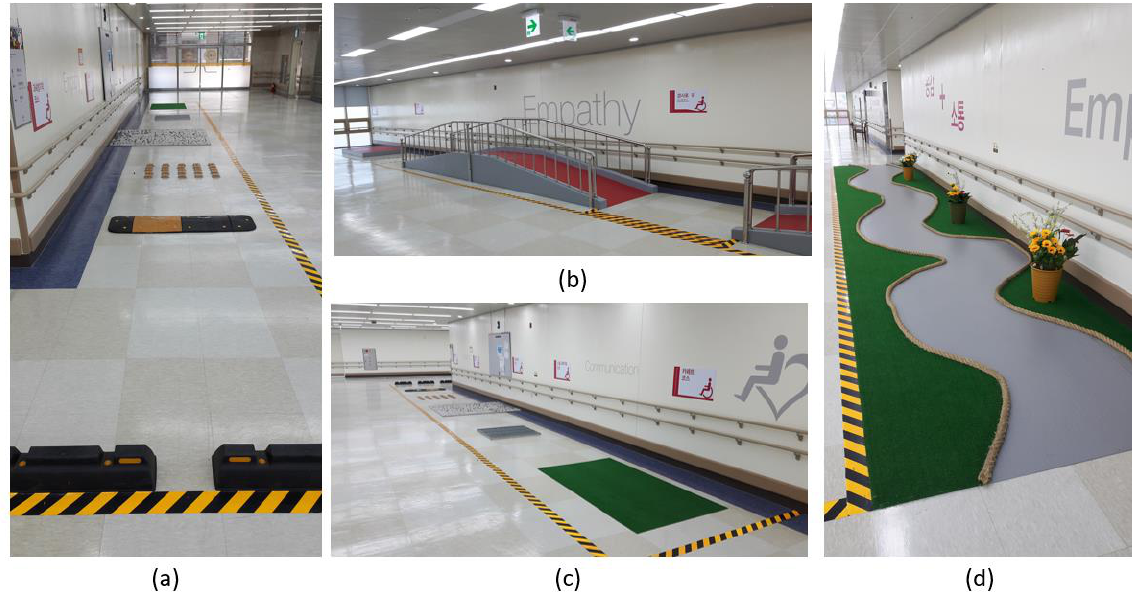
Figure 4. ( a ) speed bumps, braille beam block, general-purpose road curb; ( b ) ramps of similar standards to those installed in Korean public institutions and out-doors; ( c ) various types of flooring panels with different materials and roughness; and ( d ) general curve reflecting road conditions.